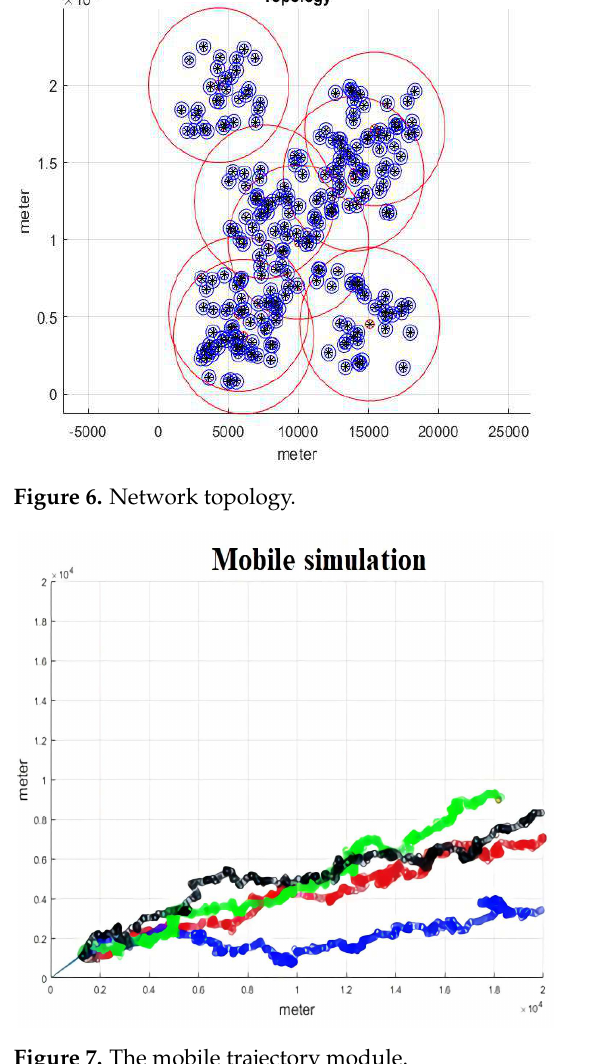
Figure 7. The mobile trajectory